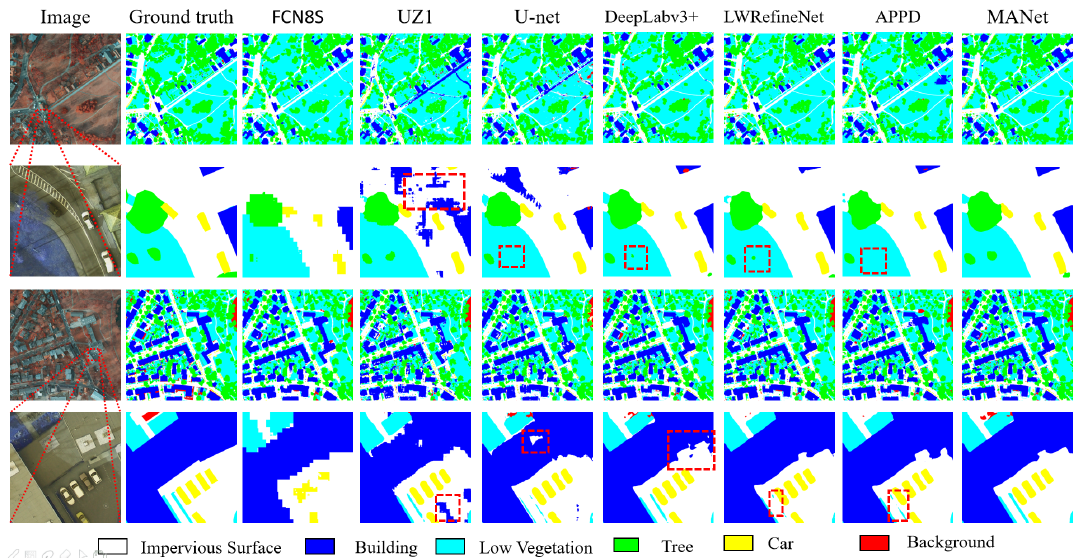
Figure 6. Visual comparison of seven models on the Potsdam dataset.